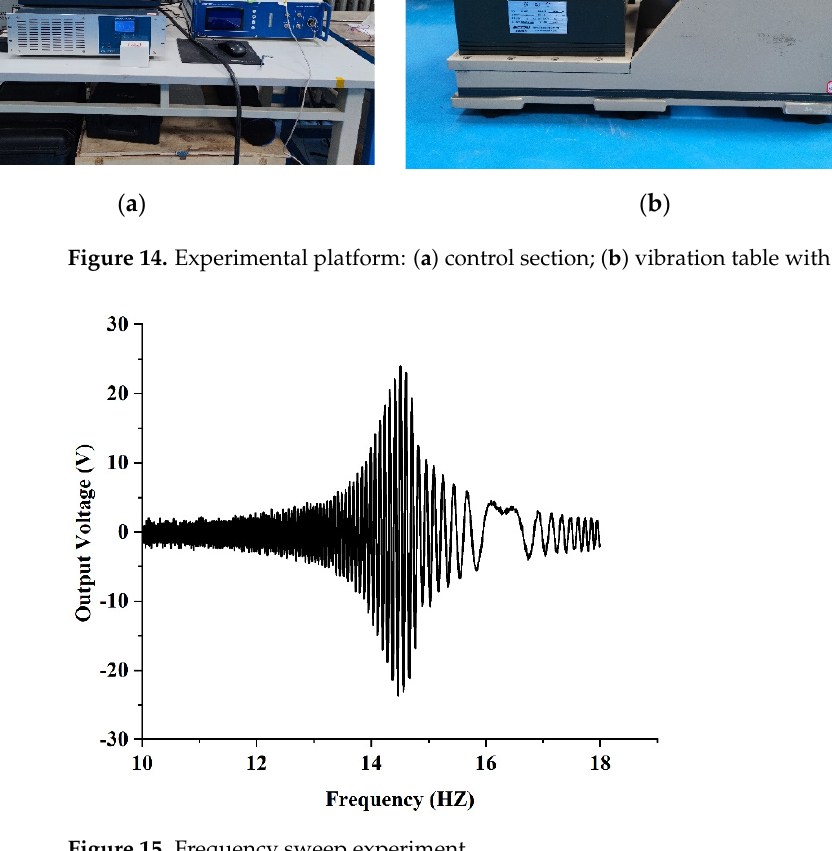
Figure 16. Residency experiment. 5. Conclusions This paper outlines a design for a linear-arc composite beam piezoelectric energy harvester (PEH-C). The corresponding coupled governing equations were derived using the generalized Hamilton principle, laying the foundation for subsequent in-depth re- search. After this, the finite element simulation was performed in the COMSOL software to simulate the output voltage, stress distribution, and resonance frequency of the PEH-C under different curvatures. The impact of changes in the curvature on the PEH-C were then analyzed. Finally, the PEH-C with a curvature of 40 m (cid:2879)(cid:2869) was prepared and an ex- perimental platform was built to verify the correctness of the relevant analysis. The fol- lowing main conclusions were obtained from the simulation and experiment: (1) The PEH-C was numerically simulated using COMSOL software to determine the relationship between the nonlinear restoring force and the transverse displacements. Then, curve fitting was performed to obtain the equation for the nonlinear restoring